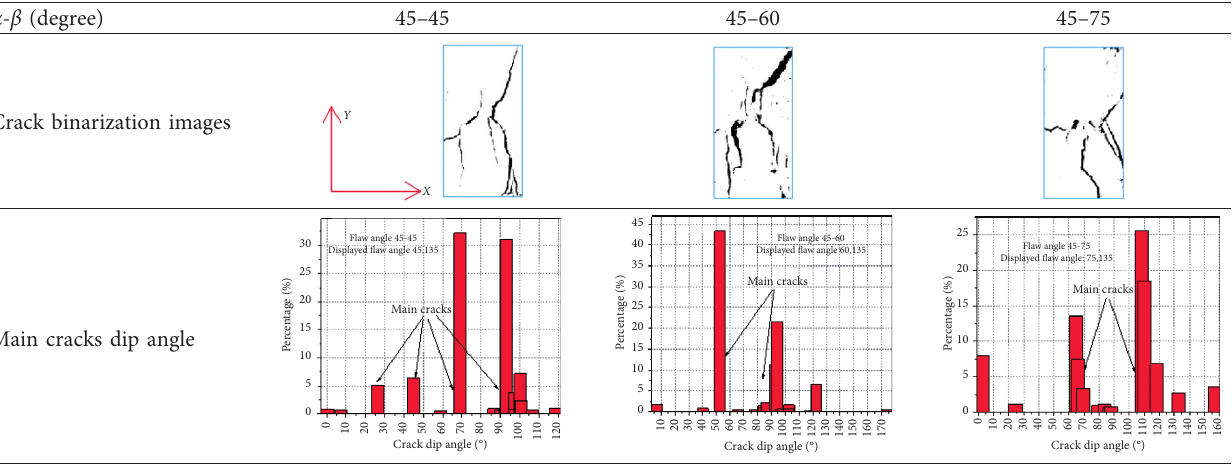
Table 6: Crack binarization images and the distribution of main cracks dip angle in ultimate failure modes of the specimens containing two parallelogram flaws at α � β � 45 ° , α � 45 < β � 60 ° , and α � 45 < β � 75 ° under uniaxial compression.